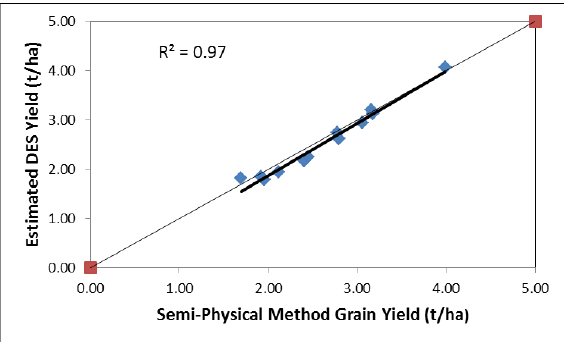
Figure 10: Comparison of DES yield with RS based yield